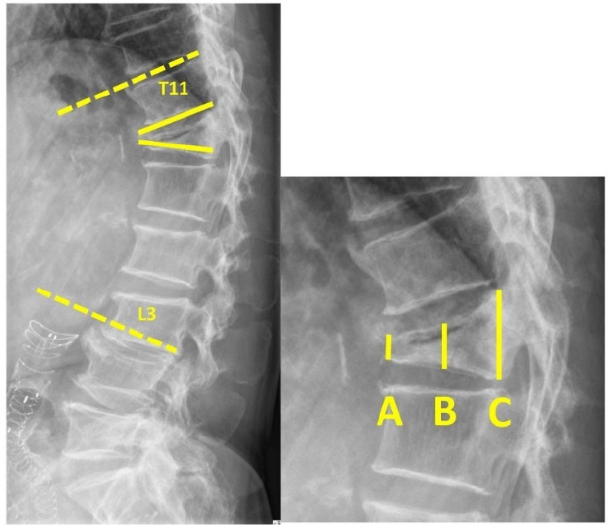
Figure 1. ( Left ) Regional kyphotic angle—the angle between the upper endplate of T11 and lower endplate of L3 (dashed line). Local kyphotic—the angle between the upper and lower endplates of the fractured vertebra (solid line). ( Right ) A—anterior VBH, B—middle VBH, C—posterior VBH (VBH = vertebral body height).